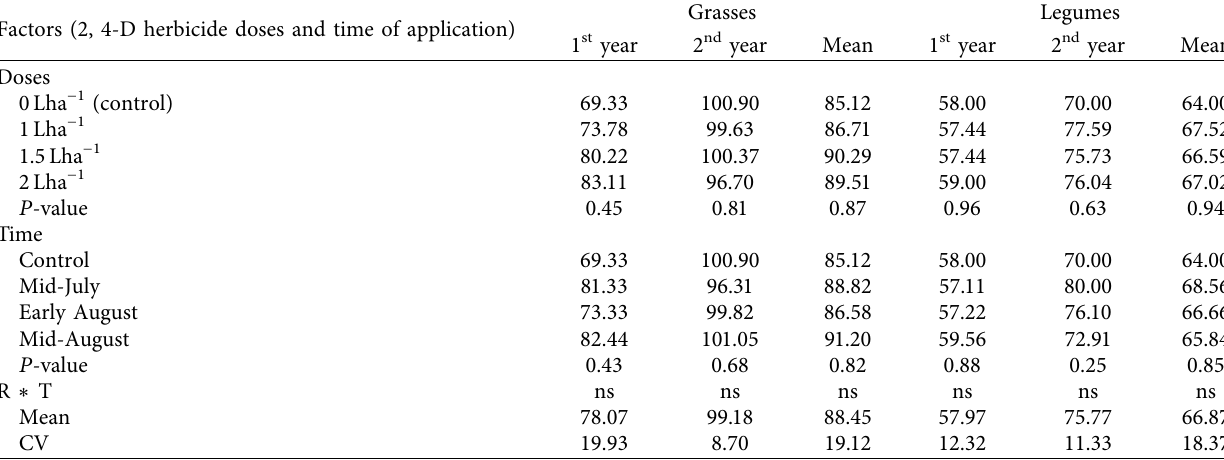
Table 8: Effect of dose and time of application of 2, 4-D herbicide on plant height (cm) of natural pasture forage portions and weeds. Factors (2, 4-D herbicide doses and time of application) Doses